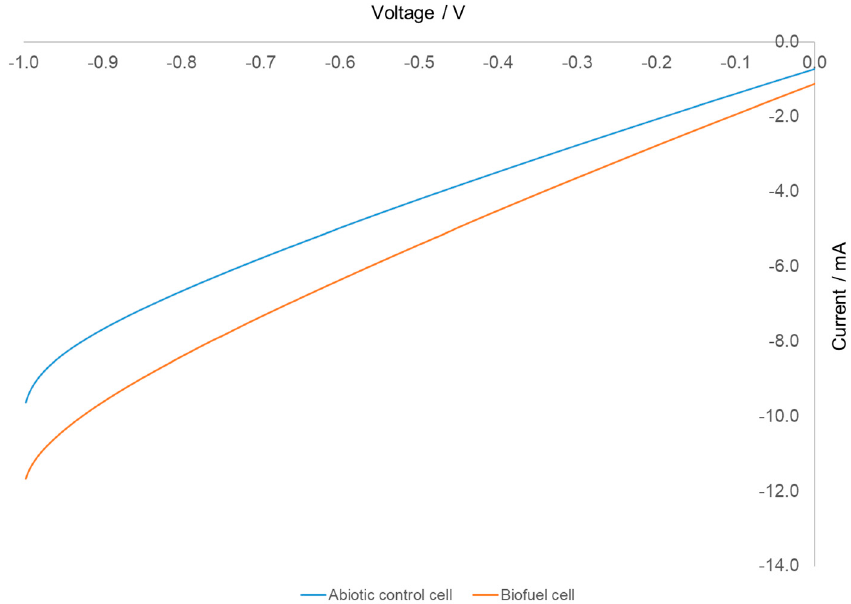
Figure 4. Linear sweep voltammetry (LSV) of the air cathode in the presence and absence of P. crysosporium inocula in PDB electrolyte.